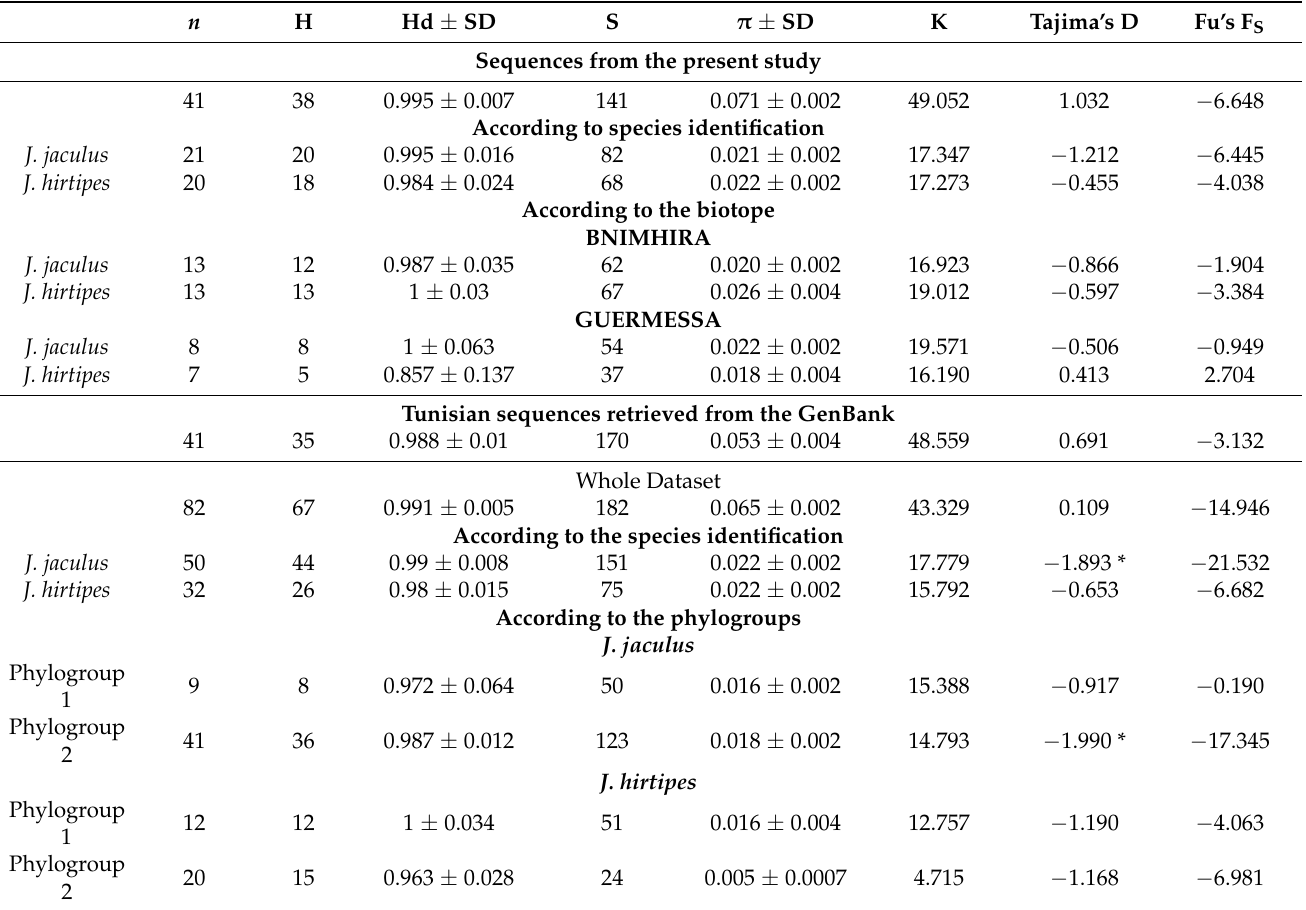
Table 4. Standard genetic statistics of Tunisian Jaculus according to rodent species, biotopes, and phylogroups.